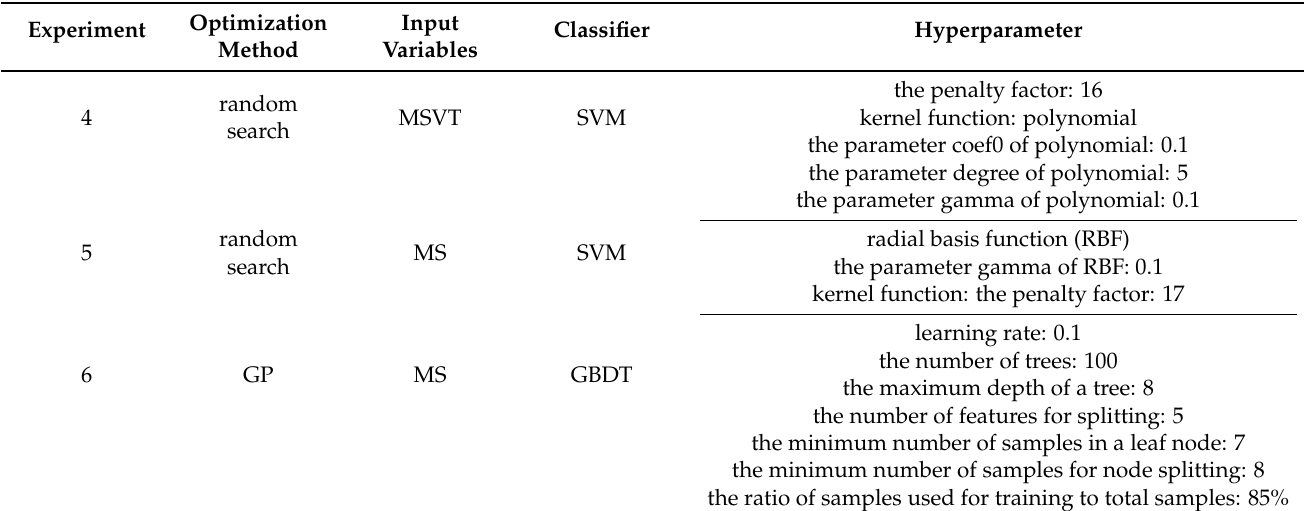
Table 9. Optimization results obtained in experiments 4, 5 and